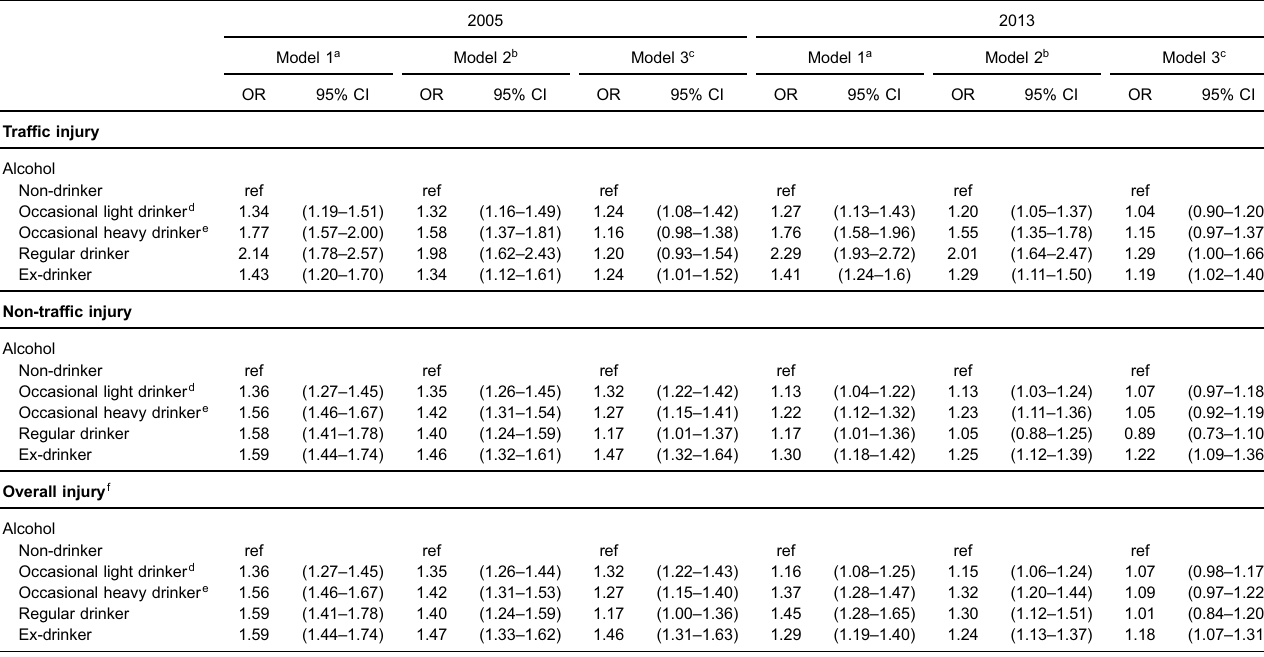
Table 4. Association between alcohol consumption and incidence of non-fatal injury in 2005 and